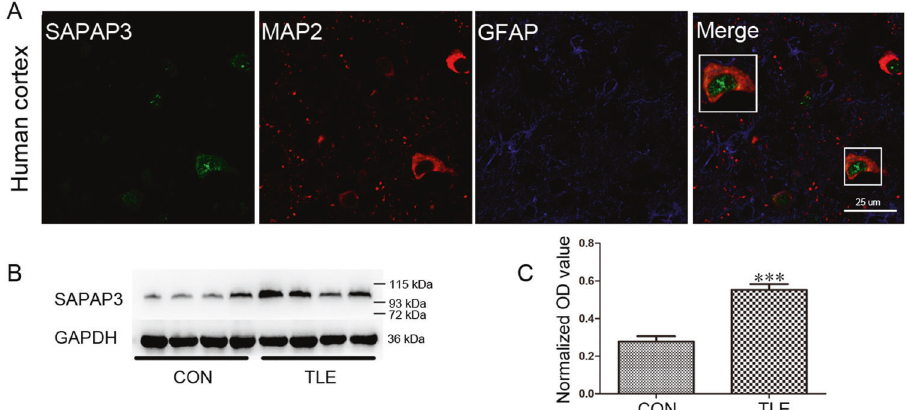
Fig. 1 Expression of SAPAP3 in the temporal cortex of patients with TLE. A Triple-label immuno fl uorescence showed that SAPAP3 (green) and GFAP (blue) were not coexpressed in astrocytes, but SAPAP3 (green) and MAP2 (red) were coexpressed in the cortical neurons of patients. The arrows indicate positive cells. B Representative western blots showing the expression of SAPAP3 in patients with TLE and controls. C The comparison of the mean OD value indicates that SAPAP3 expression in the TLE group ( n = 20) is signi fi cantly higher than that in the control group ( n = 10). Data are presented as means ± SEM. *** p <